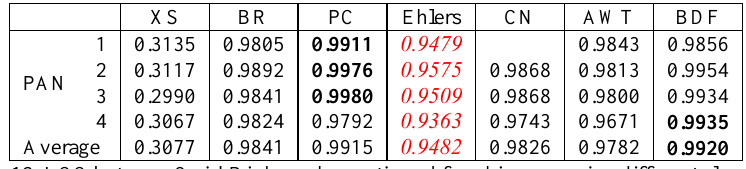
Table 12. LCC between QuickBird panchromatic and fused images using different